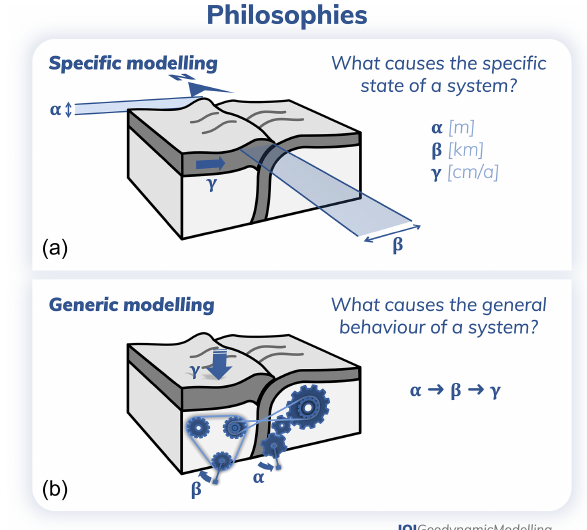
Figure 9. The two overarching modelling philosophies. (a) Specific modelling and (b) generic modelling have different scientific goals and need to be used, communicated, and reviewed